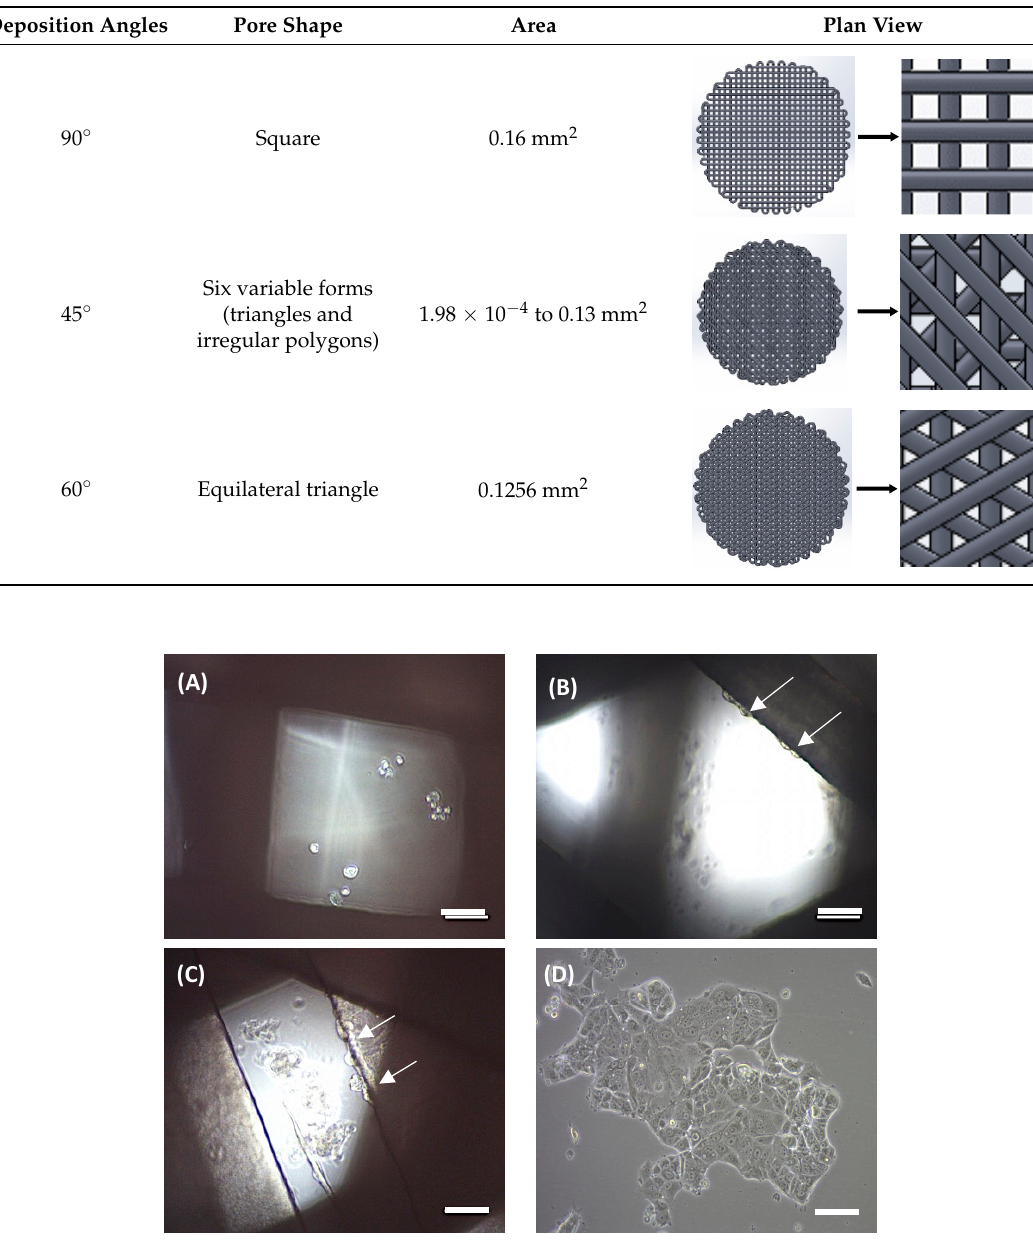
Table 2. Scaffold designs with different deposition angles: 90°, 45°, and 60°.